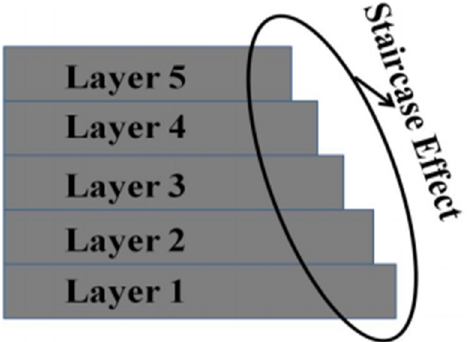
Figure 16. Schematic representation of the staircase effect in layer-based manufacturing.